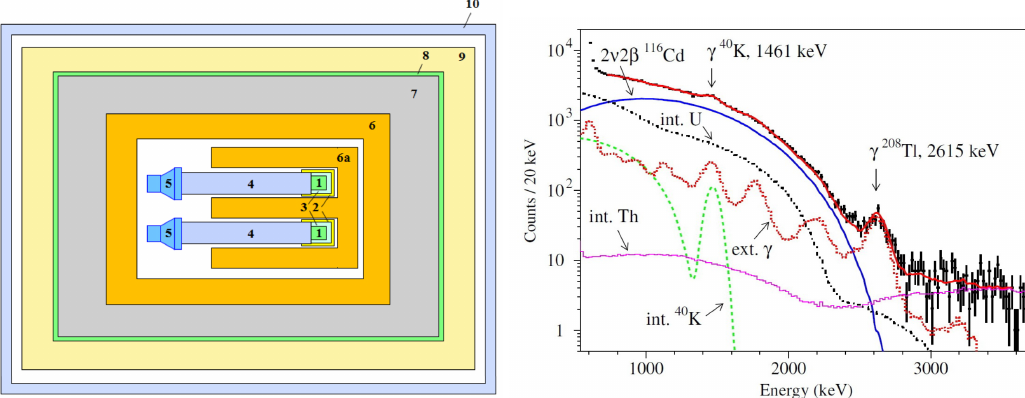
Figure 16. ( left ) Schematic view of the last AURORA set-up assembling. The two 116 CdWO 4 crystal scintillators (1) are fixed in Teflon containers (2) filled up with liquid scintillator (3) and viewed through quartz light-guides (4) by photomultipliers (5). The passive shield consisted of high purity copper (6), additional high purity copper shield (6a), low radioactive lead (7), cadmium (8), polyethylene/paraffin (9), and plexiglas box for the radon removal system (10) [68]. ( right ) The energy spectrum of γ ( β ) events accumulated over 26831 h with the 116 CdWO 4 detectors together with the main components of the background model and the 2 ν 2 β − decay contribution (blue curve) [68]. Figures reprinted from Reference [68] with permission from American Physical